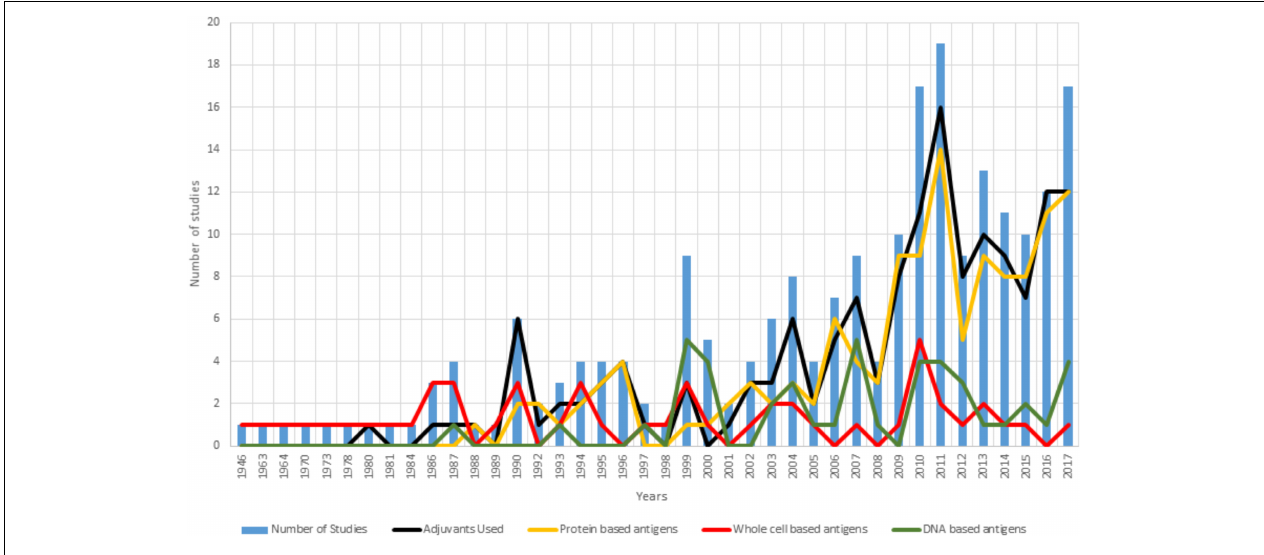
FIGURE 2 | Summary of vaccine formulations between 1946 and 2017. For each year examined, the blue bars represent the number of vaccine trials published that year. Overlayed on the trial numbers is a break down the vaccine formulation tested by inclusion of an adjuvant (black line) and the use of either a protein-based antigen (yellow line), a whole cell antigen (attenuated or in-active) (red line) or a DNA-based antigen (green line).